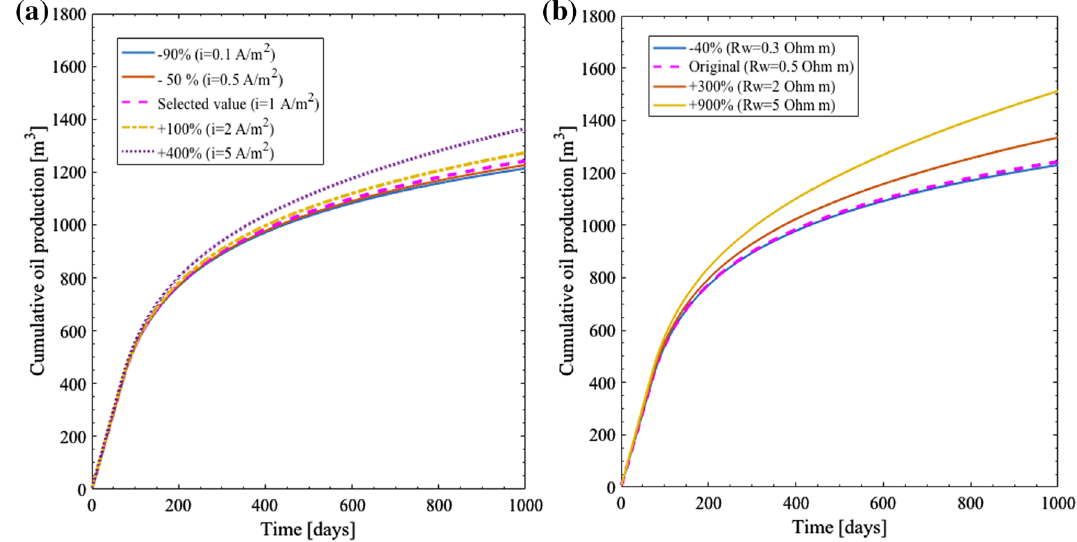
Fig. 9 Variation of cumulative oil production with a applied current density and b water